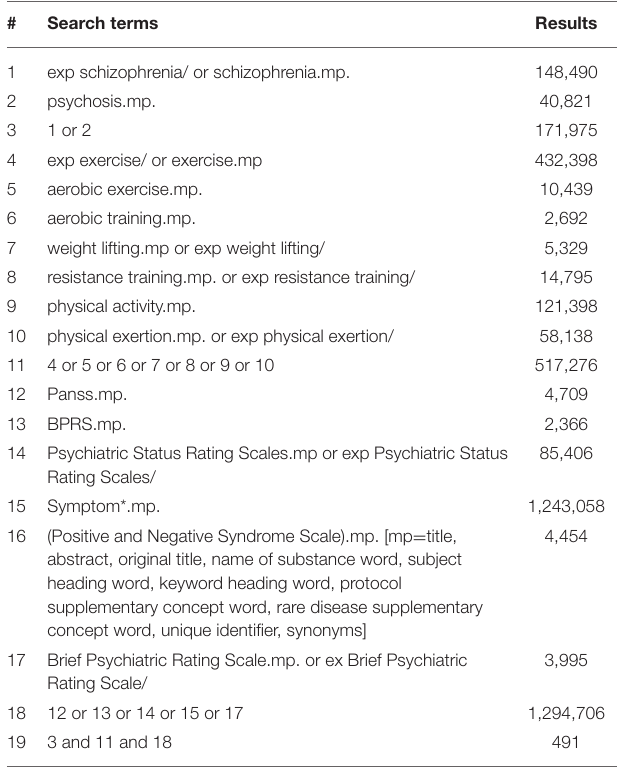
TABLE 1 | Results of the literature search strategy: MEDLINE